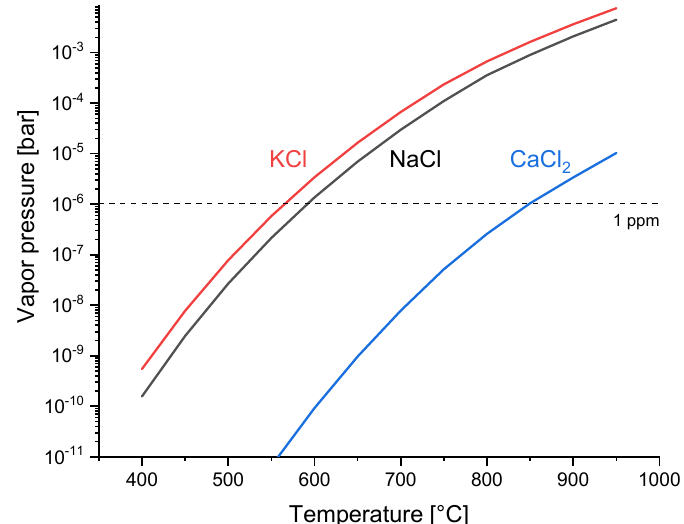
Figure 3. Vapor pressure of alkali and alkaline earth chlorides. The dashed line marks the concentration of 1 ppmv at 1 bar total pressure.